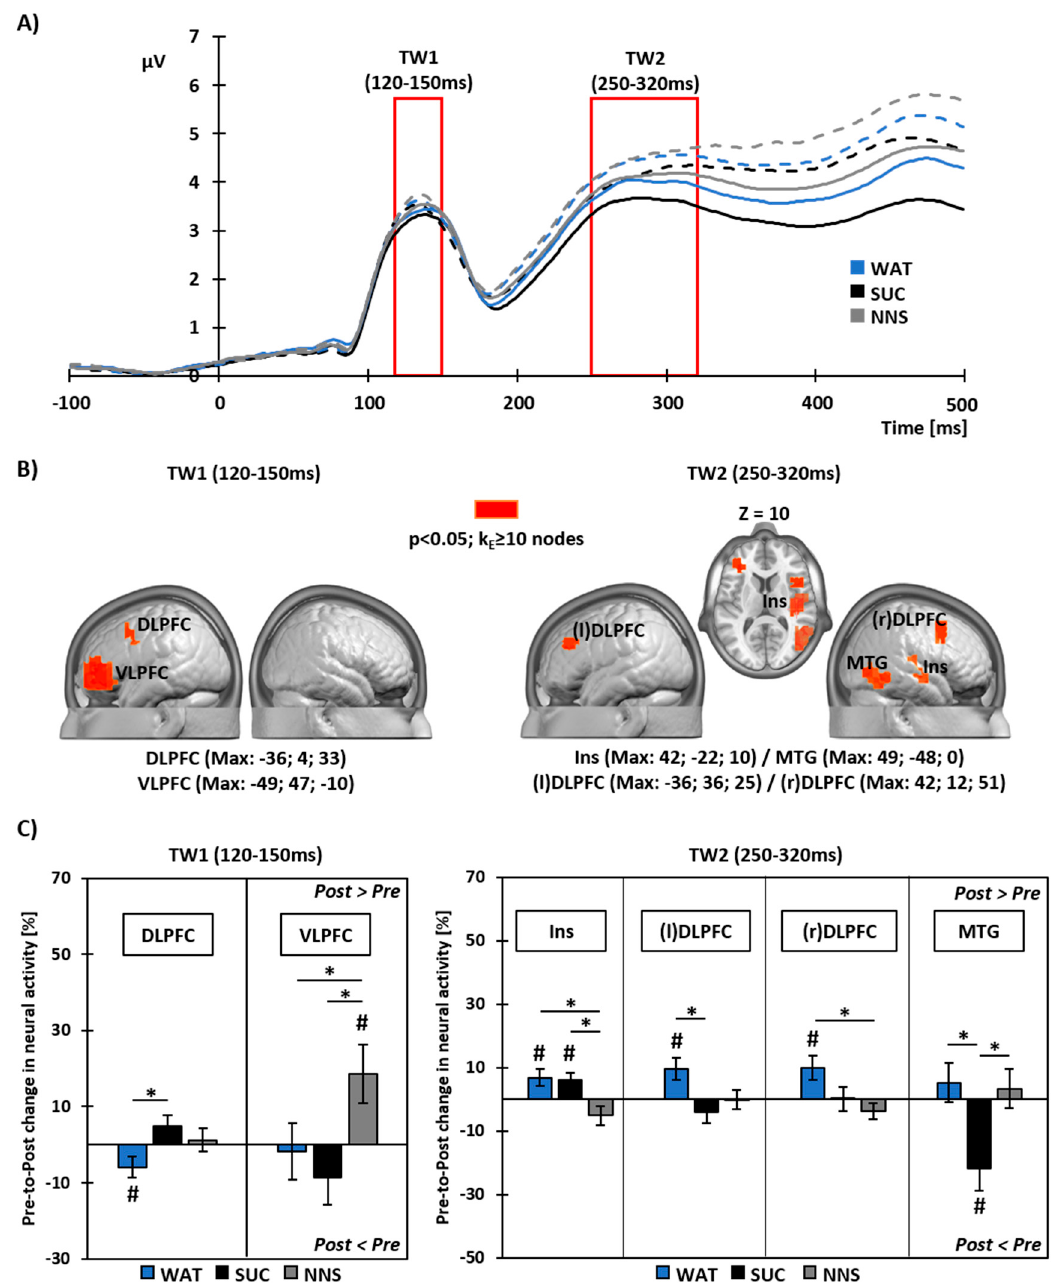
Figure 3. ( A ) Group-average Global Field Power (GFP) waveform over the peri-stimulus period ( − 100 to +500 ms from image onset). Red borders indicate the time windows of interest (TW) for subsequent neural source analyses. Solid lines illustrate the GFP during the pre-prandial recording session and dotted lines show GFP during the post-prandial recording session. ( B ) Visualization of brain regions showing a main effect of Beverage in the whole brain analyses on pre- to post-prandial changes in neural activity. Talairach coordinates ( x , y , z ) indicate the position of the source node showing maximal statistical differences. ( C ) Results of post-hoc analyses on changes in neural activity within each region of interest. Bar plots detail the direction of changes in each region of ( B ) and for each Beverage condition. Data are shown as mean ( ± SEM). *: p < 0.05 for paired t -tests (two-tailed) between Beverage conditions. # : p < 0.05 for one-sample t -tests vs baseline (pre-prandial). VLPFC: ventrolateral prefrontal cortex. Ins: insula. (l)- & (r)DLPFC: left & right dorsolateral prefrontal cortex. MTG: Middle Temporal Gyrus. WAT, SUC, NNS: Water-, Sucrose-, NNS-beverage conditions.